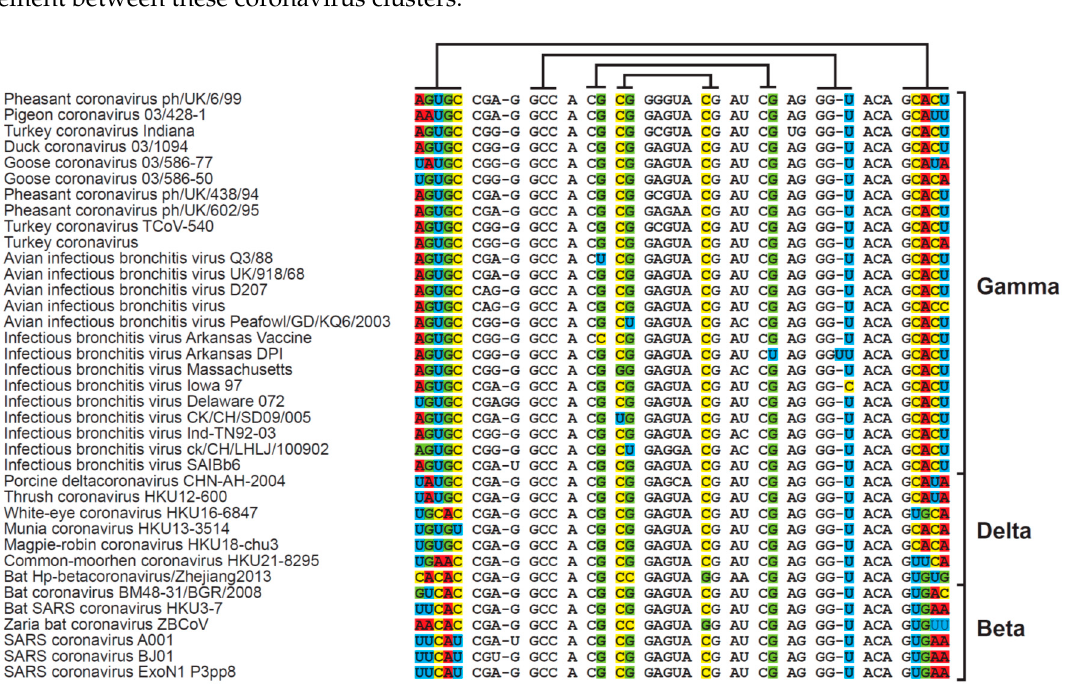
Figure 2. s2m coronavirus sequence motifs. For each genotype, one representative accession was chosen to illustrate the conserved nature of s2m both on a primary (‘sequence’) level and on a secondary (stem-loop structure) level. Lines above alignment indicate co-varying/stem-forming elements and columns with non-conserved bases for these nucleotide positions have been color coded.